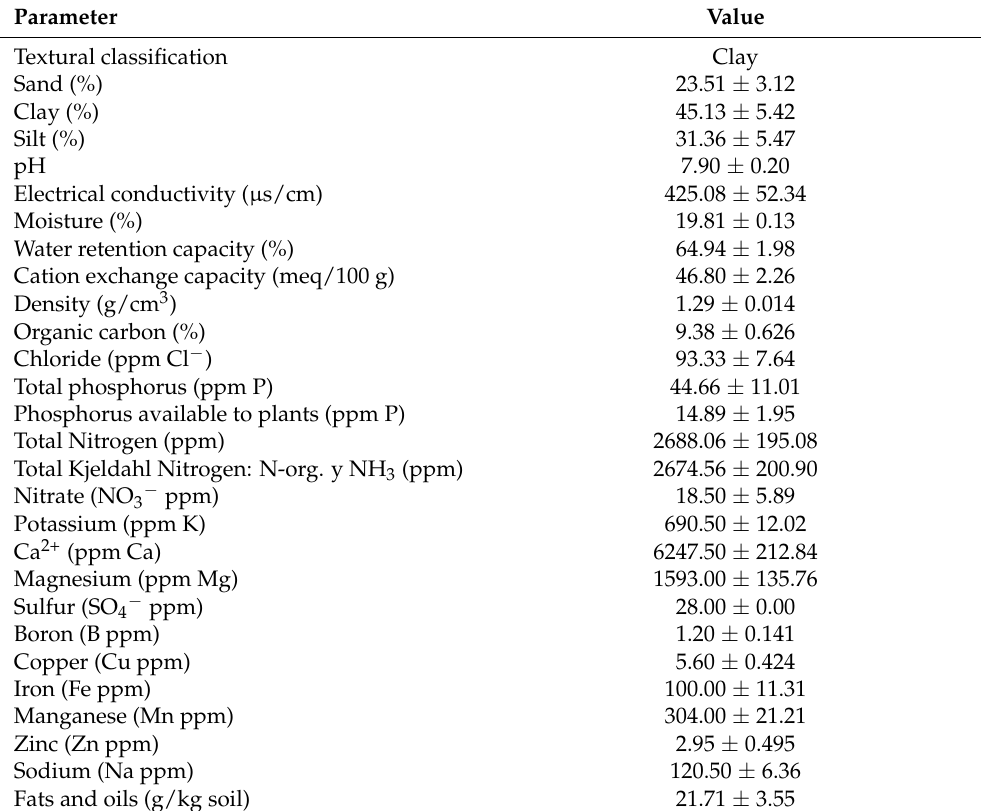
Table 10. Physicochemical characteristics of the evaluated